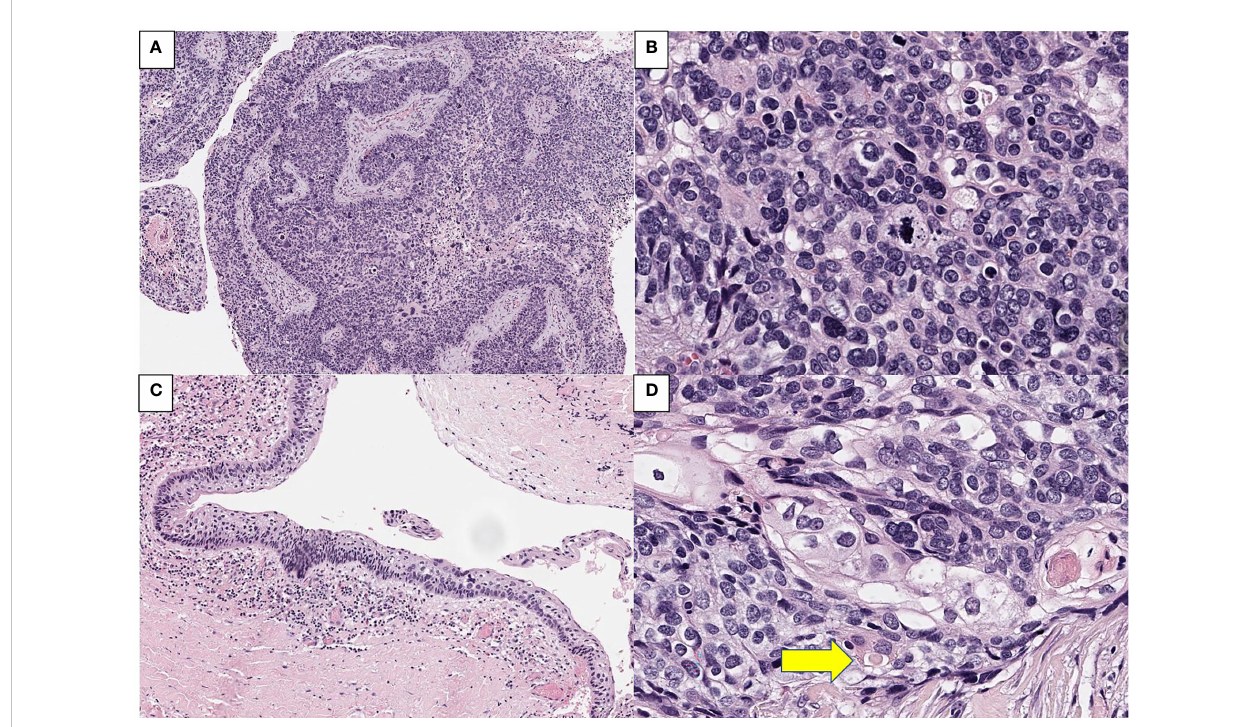
FIGURE 2 Representative H&E images of the tumor. (A) An in fi ltrative tumor with connection to cystic lining with high grade squamous intraepithelial lesion (x 100). (B) the tumor cells showed severe nuclear atypia and clear, vacuolar cytoplasm (x 800). (C) adjacent squamous cell carcinoma in situ lesion with no direct connection to normal skin epithelium (x 200). (D) cells with clear squamous differentiation and keratin pearl (arrow,